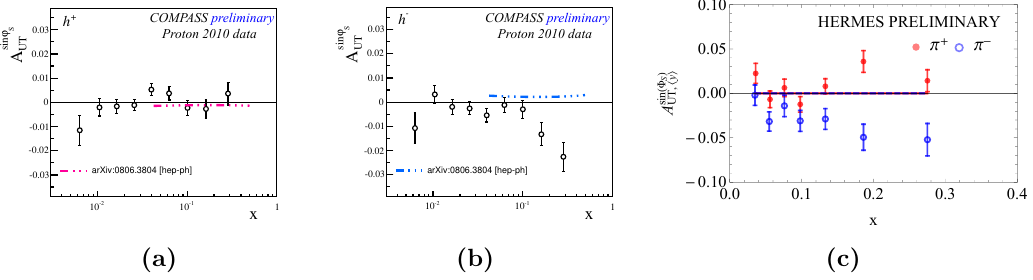
Figure 18. Subleading-twist asymmetry A sin (cid:30) S